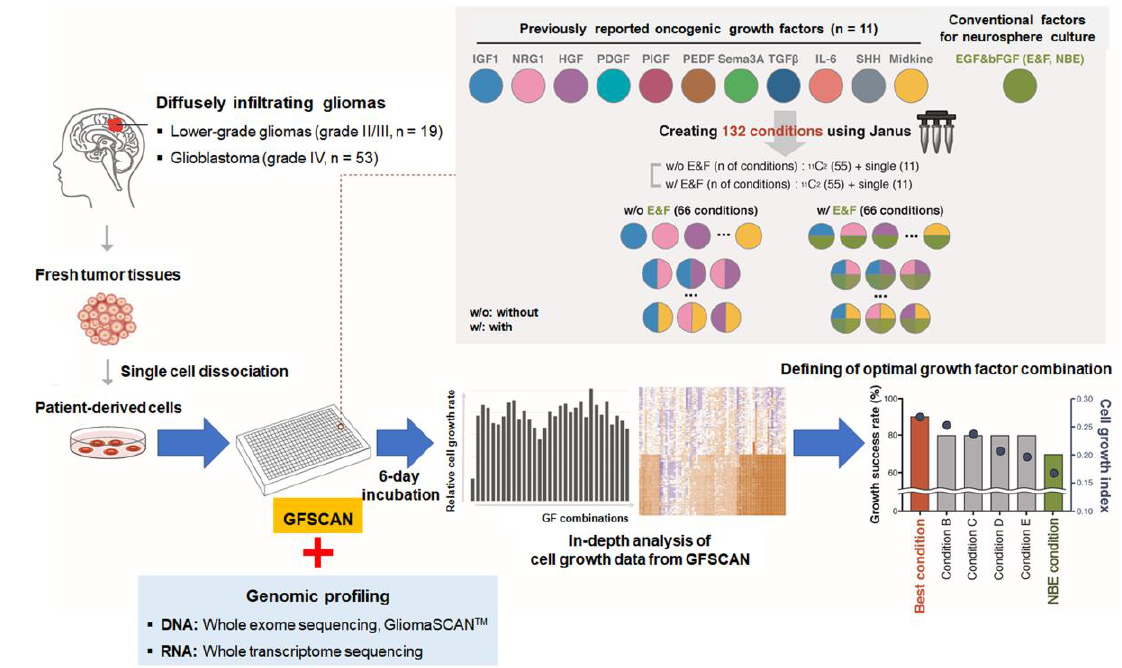
Figure 1. Schematic workflow of the Growth Factor SCAN (GFSCAN) to identify optimal growth factor conditions for DIGs. For 19 LGG and 53 glioblastoma GSCs, GFSCAN was performed to evaluate the effects of 132 growth factor combinations on cell growth, and their genomic characteristics were determined by next-generation sequencing.